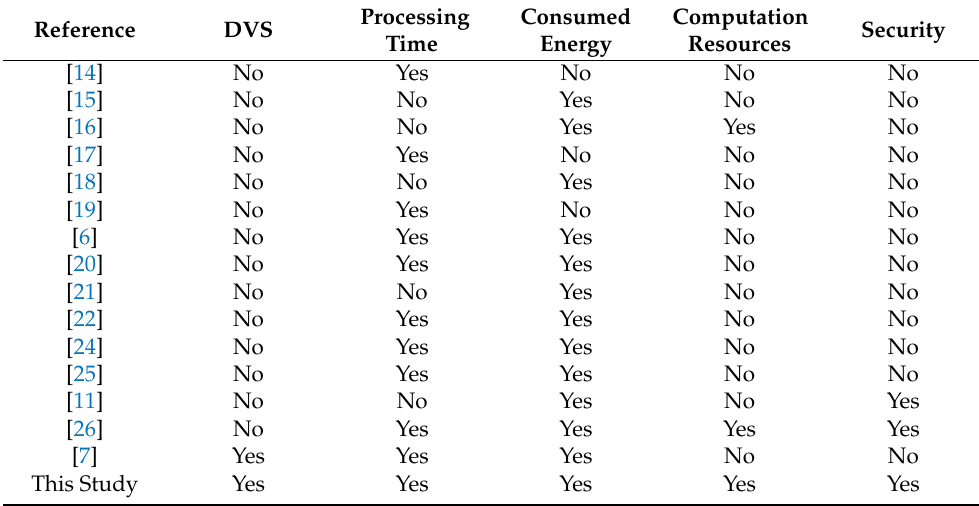
Table 1. Comparison.